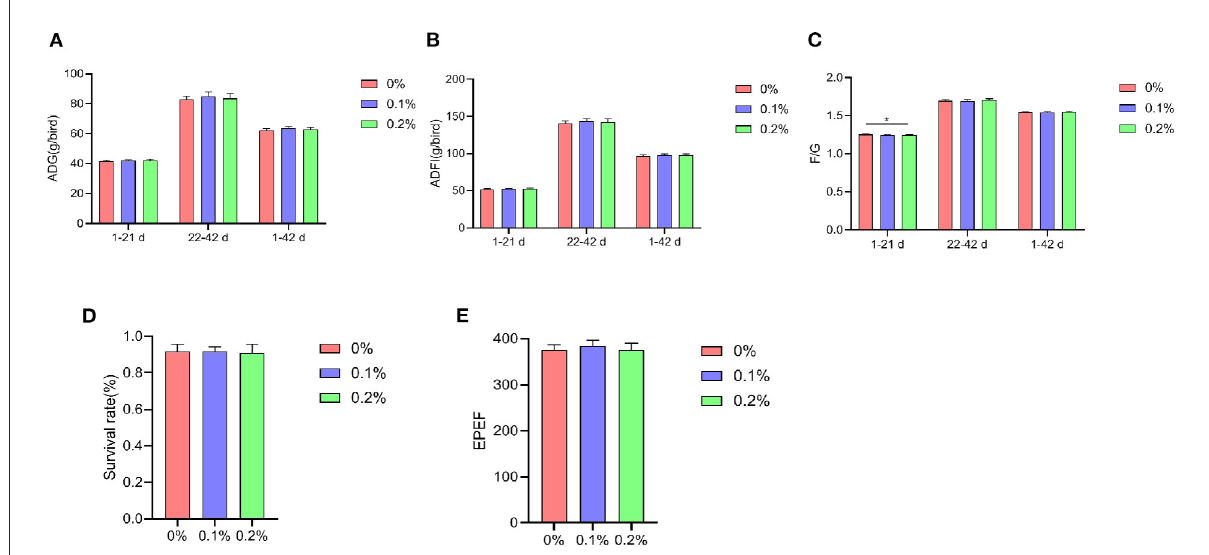
FIGURE1 Effect of PC addition to diets on the growth performance in AA + broilers. (A) Average daily gain. (B) Average daily feed intake. (C) Feed-to-weight ratio. (D) Survival rate. (E) European productivity efficiency factor. “*” means indicates a significant difference ( P < 0.05). No “*” indicates that the difference is not significant ( P >